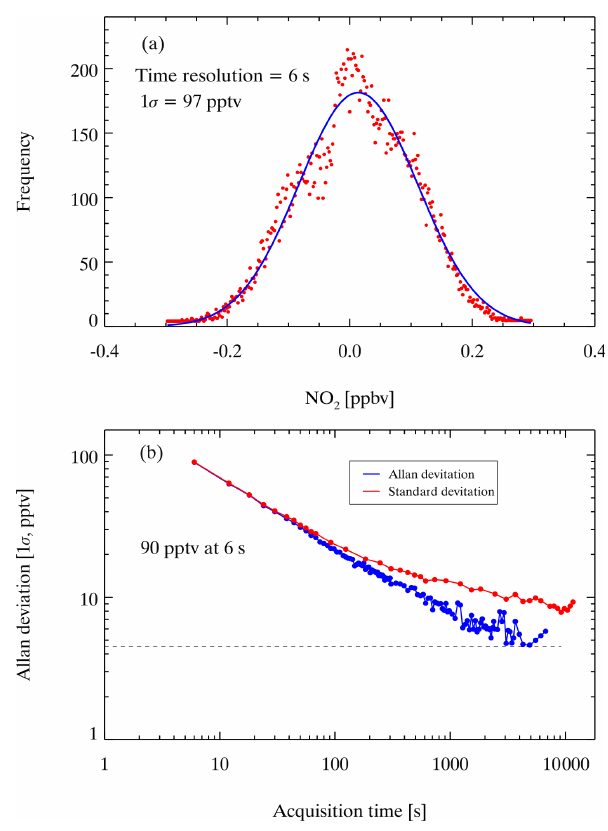
Figure 11. Instrument performance with different integration times. (a) The standard deviation of the measurements of NO 2 with a 6s integration time. (b) Allan deviation plots for measurements of NO 2 with a 6s integration